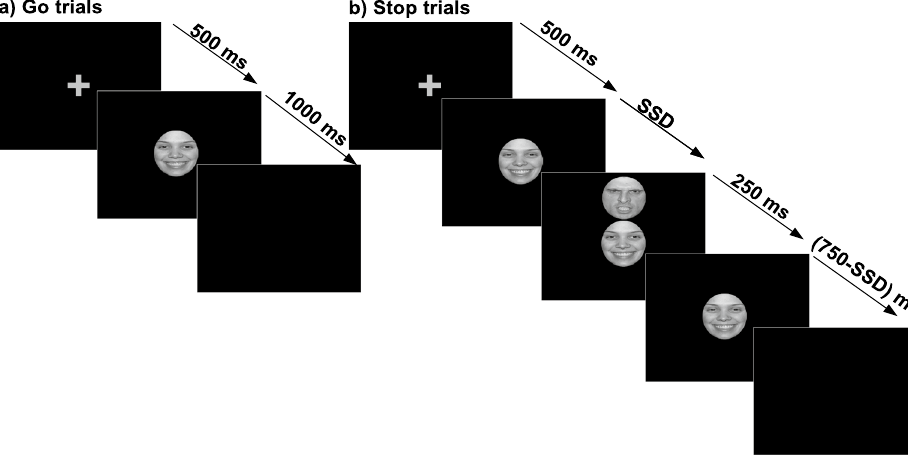
Figure 1. Schematic of Emotional Stop Signal Task. An example of a go and a stop trial. ( a ) During go trials, participants were required to press the left arrow key for male faces and the right arrow key for female faces. ( b ) During stop-trials, they were required to withhold their motor response (signaled by a face at the top of go face with irrelevant happy, angry, or neutral emotions). The stop-signal followed the go-signal after a variable time delay called stop-signal delay (SSD). The SSD was set based on a staircase procedure separately for each stop- signal condition to get stop-performance at approximately 50%